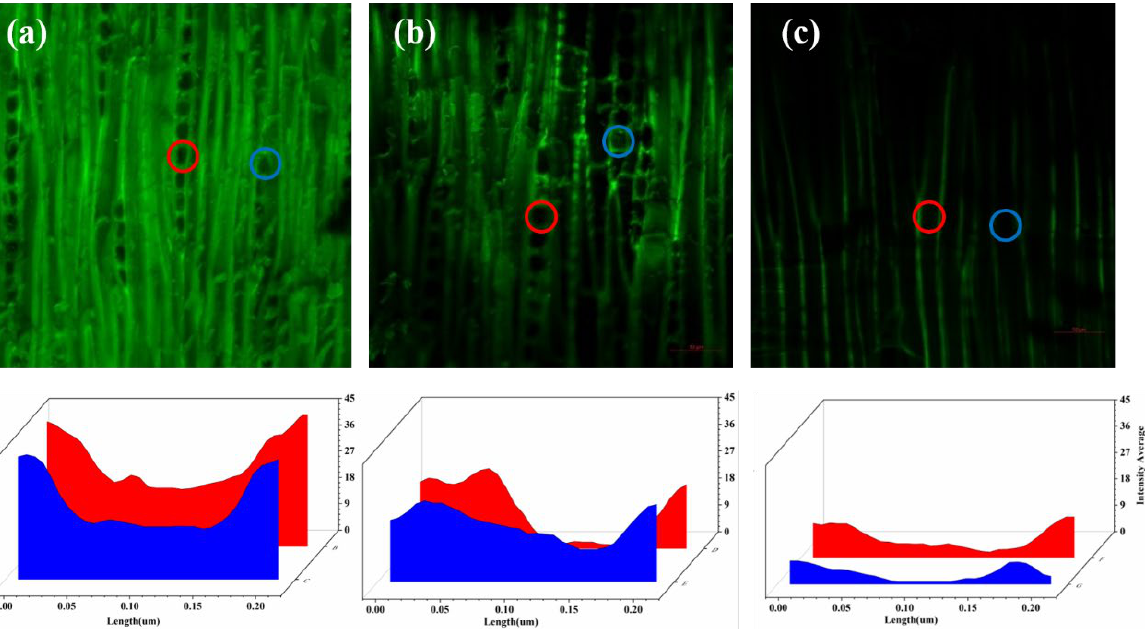
Figure 7. Confocal fluorescence figure of NW and CW under blue light with a wavelength of 488 nm. ( a ) Confocal fluorescence figure of NW. ( b ) Confocal fluorescence figure of CW-1. ( c ) Confocal fluorescence figure of CW-2. Circles indicate the regions of interest for the analysis of the fluorescence intensity by confocal microscopy at corresponding positions of the